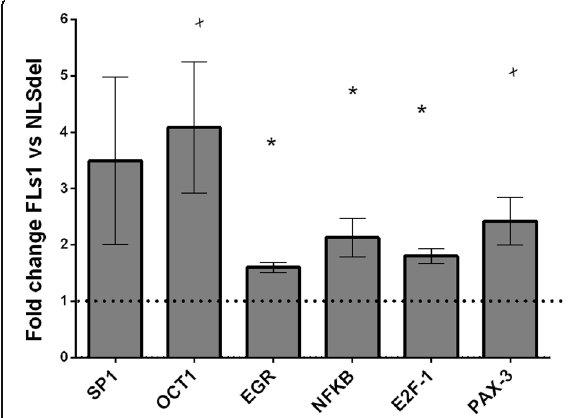
Fig. 8 Cell growth-related transcription factors regulated by the nuclear translocation of syndecan-1. Results are shown from a TranSignal ™ Protein-DNA array, performed with nuclear extracts from cells transfected with full-length syndecan-1 (FLs1) and syndecan-1 lacking the nuclear localization signal (NLSdel). Transcription factors expressed at levels that exceeded a 1.5-fold change were considered differentially expressed. The bars represent the average of at least two experiments; error bars represent the SEM. * p<0.05, based on one-sample t-test against the theoretical value 1. x p <0.1 indicates a trend observed in all three experiments ( p =0.056 for OCT1 and 0.08 for